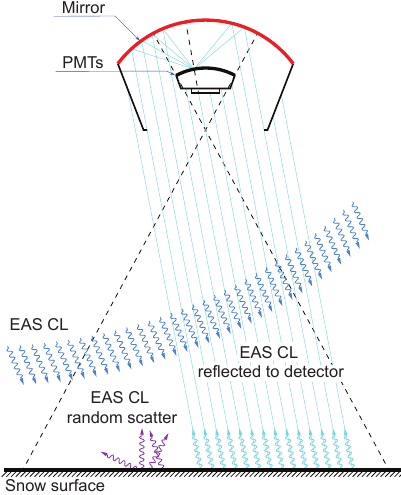
Figure 1. The detector optical